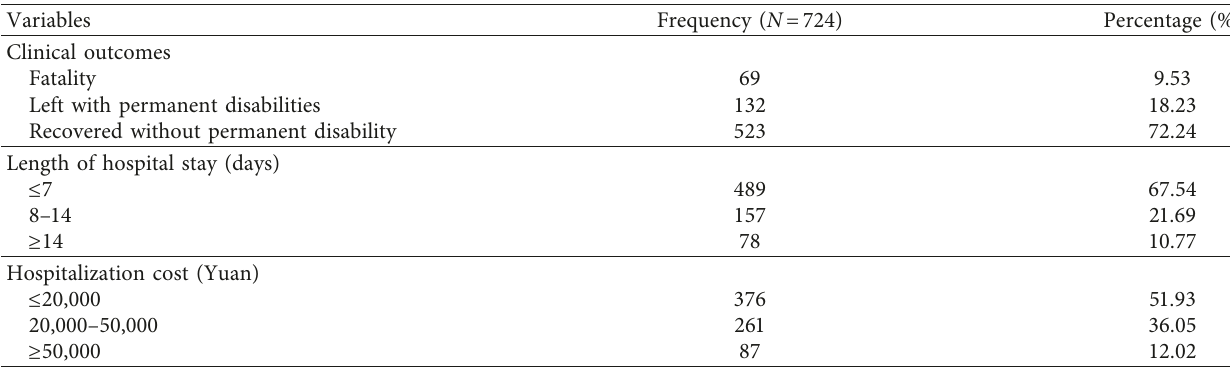
Table 4: Clinical outcomes and hospitalization characteristics of shared bicycle-related injuries.